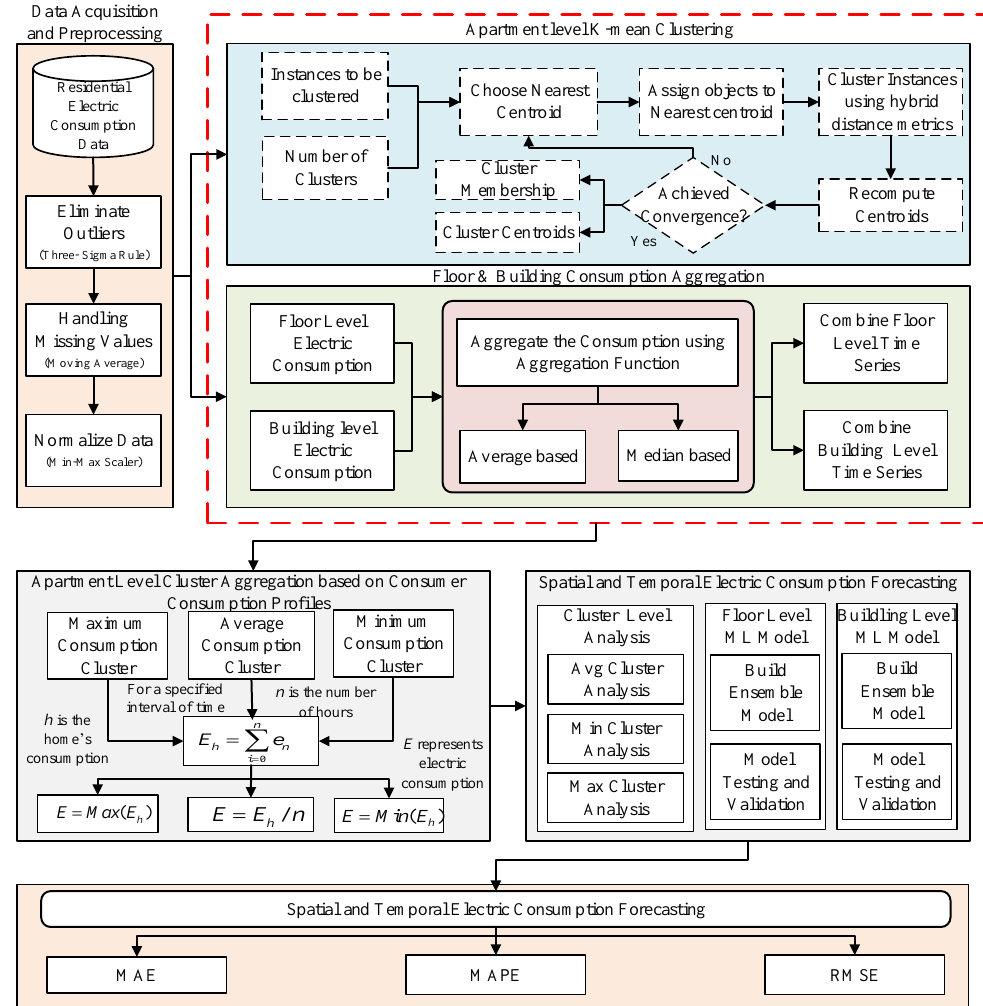
Figure 1. A Spatial-Temporal Ensemble Forecasting Architecture based on Clustering